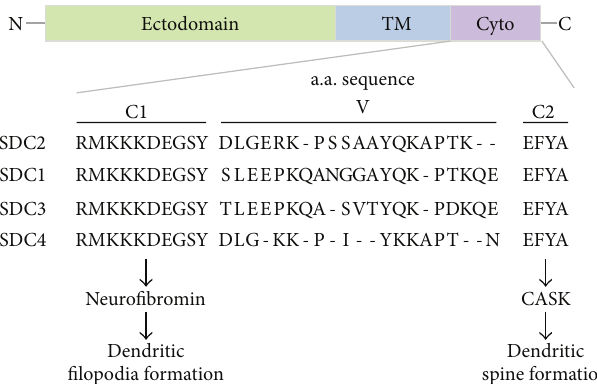
Figure 1: Schematic structure and amino acid sequences of syndecans. C1, conserved domain 1; C2, conserved domain 2; Cyto, cytoplasmic domain; SDC2, syndecan-2; SDC1, syndecan-1; SDC3, syndecan-3; SDC4, syndecan-4; TM, transmembrane; V, variable